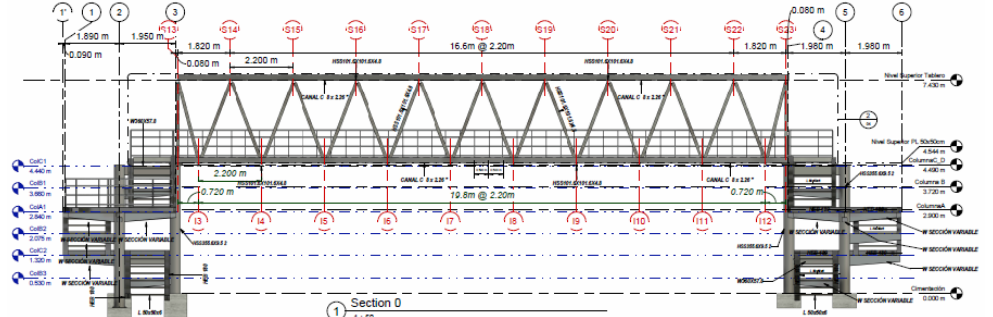
Figure 4. Lateral view of the design of the pedestrian bridges under study (schematic view).